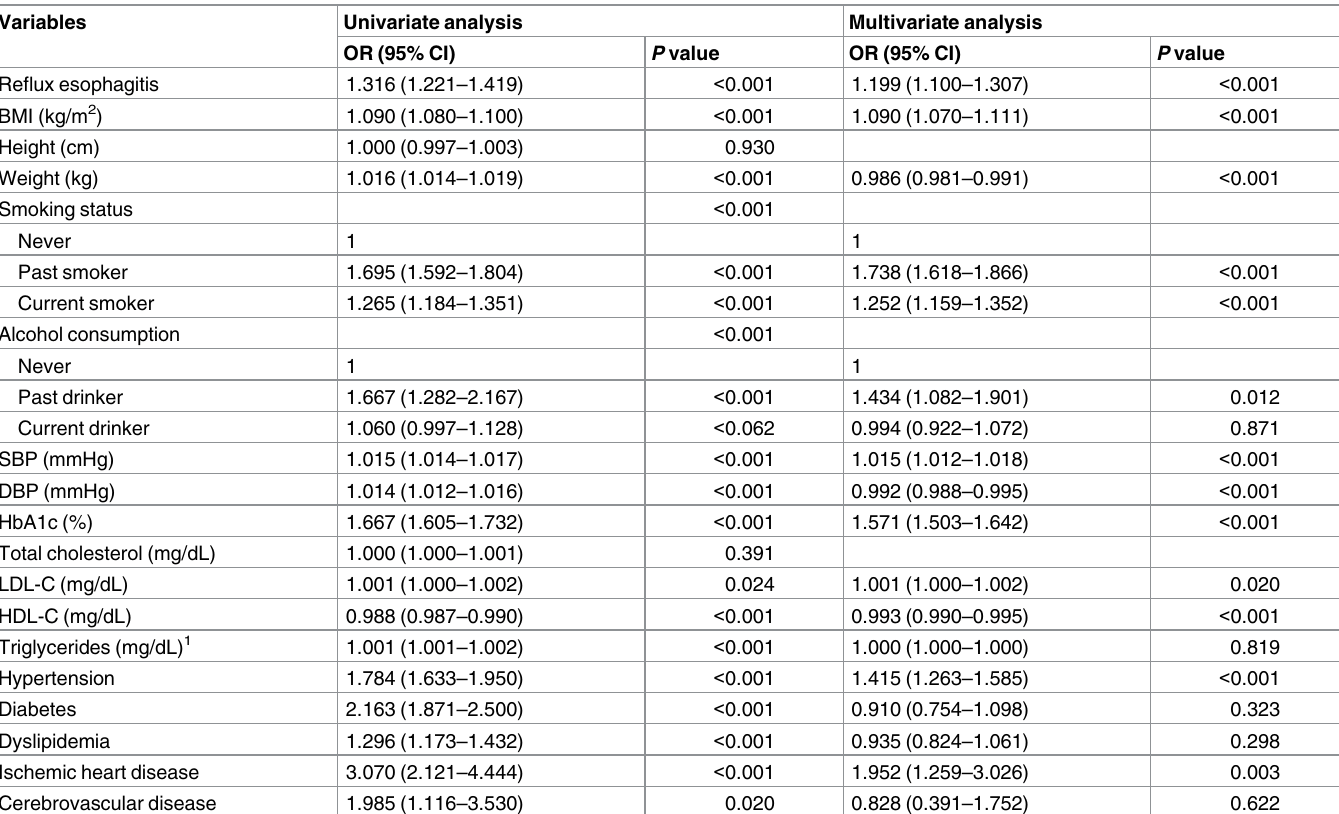
Table 1. Cross sectional univariate and multivariate analyses of the association between reflux esophagitis and coronary arterycalcium